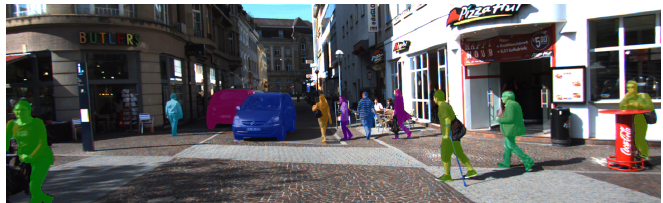
Figure 9. Example of the multi-object tracking and segmentation system (MOTS).